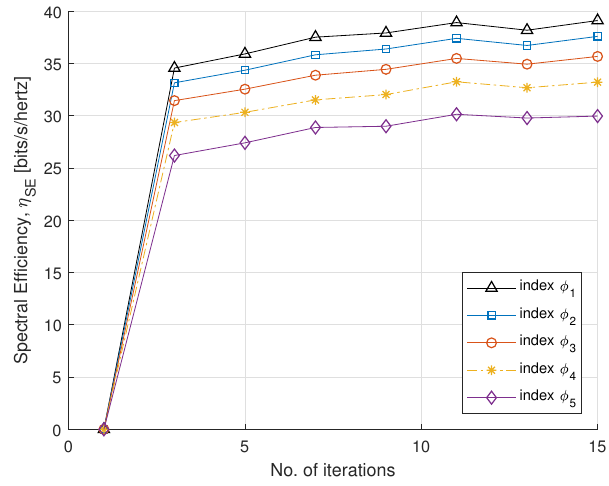
Figure 3. SE vs. number of